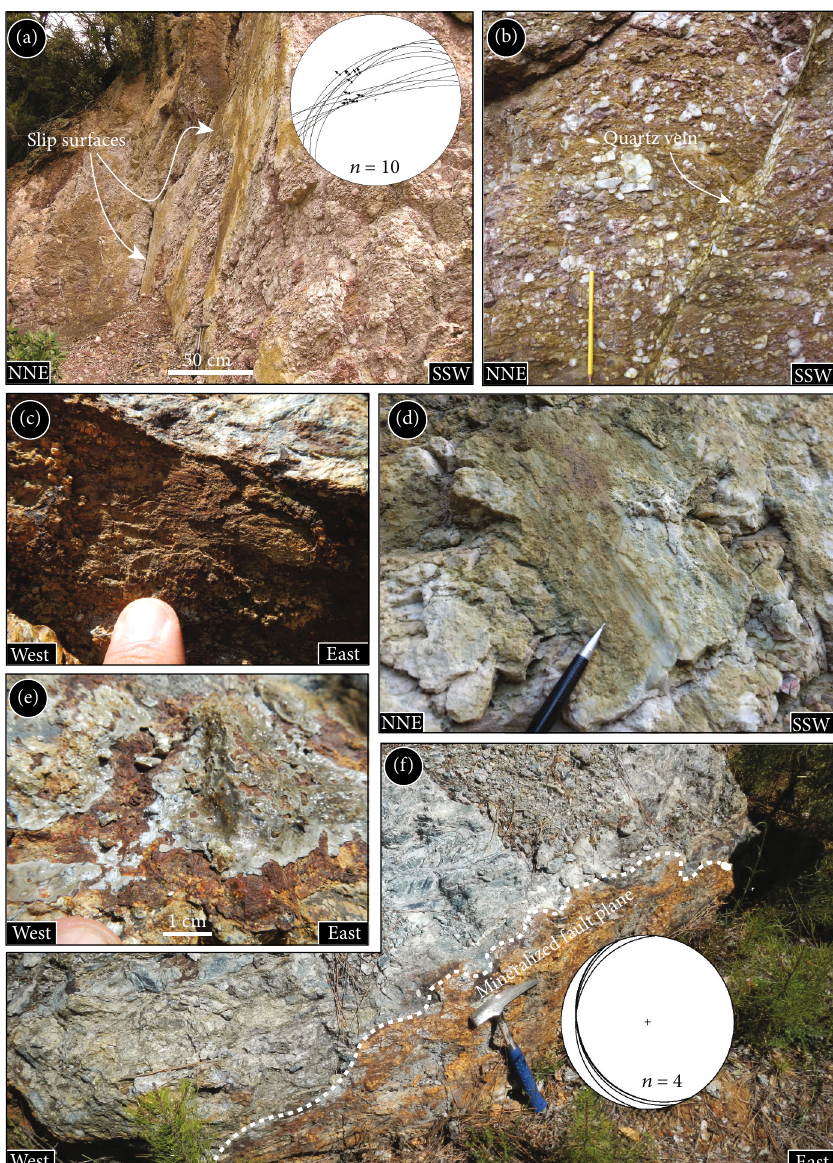
Figure 3: Examples of faults, minor structures, and evidences of hydrothermal fl uid circulation. (a) A fault zone a ff ecting the Verrucan group, showing yellowish patinas due to the hydrothermal fl uid circulation. (b) Detail of a Qz-mineralized fracture a ff ecting rocks of the Verrucano group. (c) slickenlines along the fault plane. (d) Detail of slicken lines along the fault plane in (a). (e) Detail of Fe-hydroxides and chalcedony coat. (f) A LANF a ff ecting the ophiolite of the Ligurian unit characterized by Fe-hydroxides and chalcedony